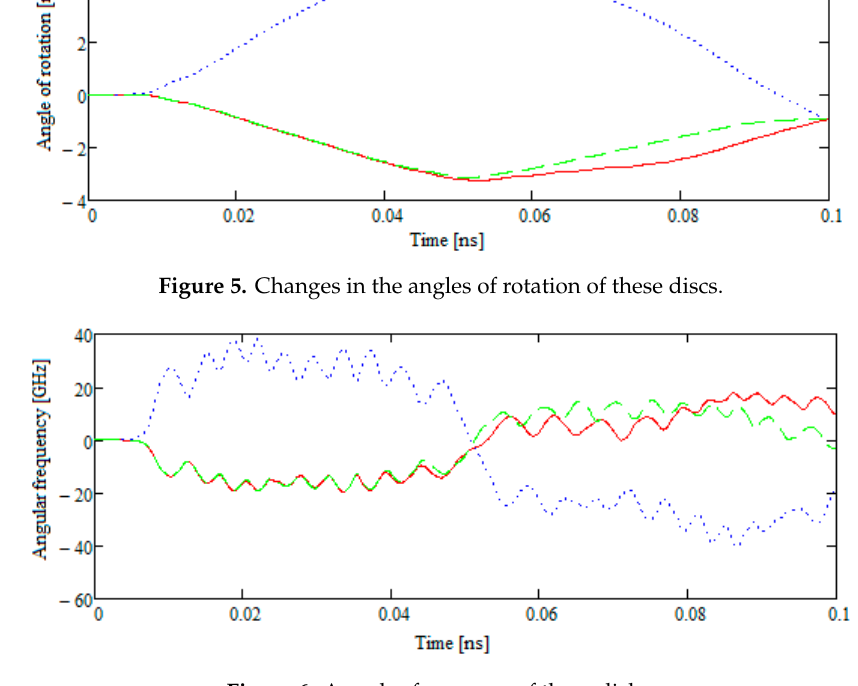
Figure 6. Angular frequency of these disks.